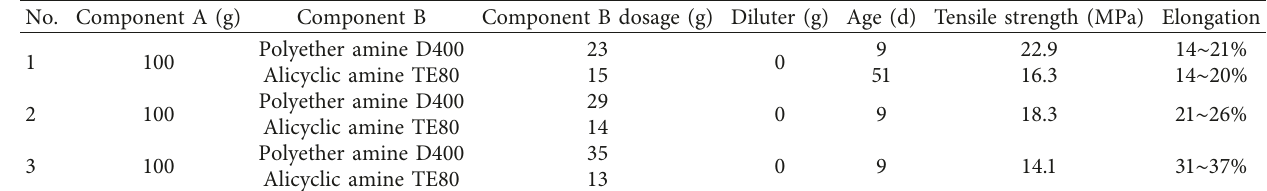
Table 2: Performance of polyurethane-modified elastic